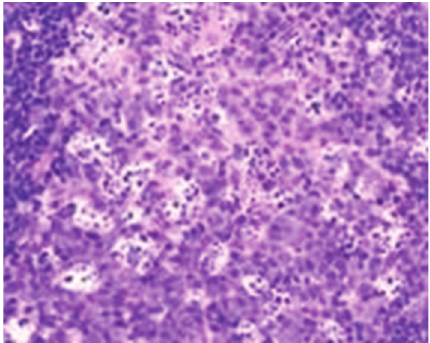
Figure 3: Treated group: 12 hours in SAP rat expansion of lymph sinuses, hyperplasia of sinus cells, and infiltration of small part of some lymphocytes, HE × 200.